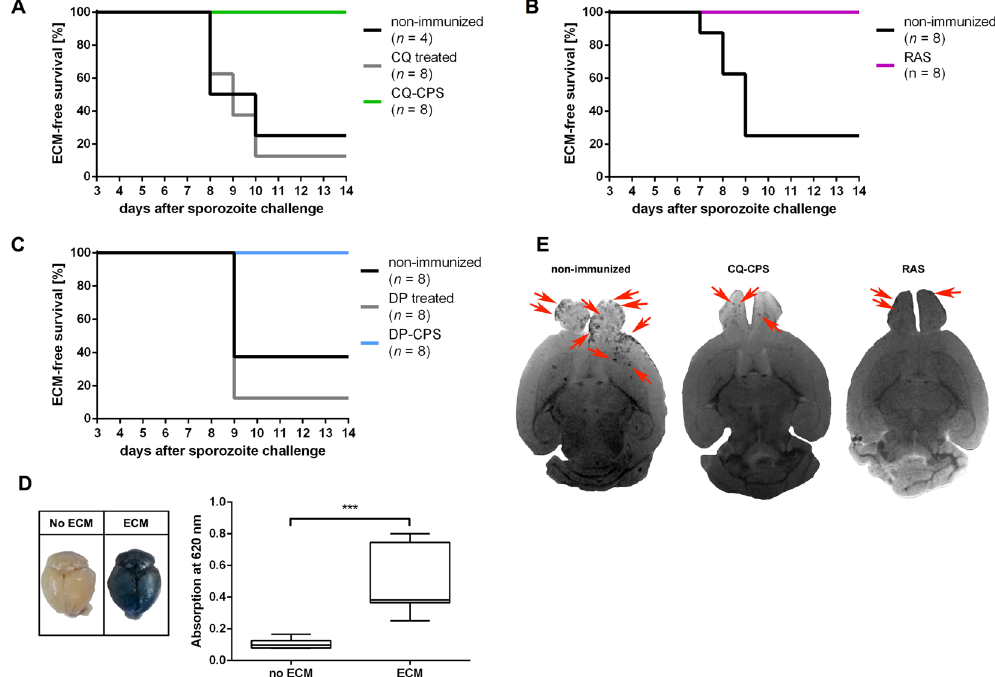
Figure 1. A single CPS or RAS immunization protects mice against experimental cerebral malaria. ( A ) ECM- free survival following a challenge with 10 3 Pb ANKA SPZ i.v. in previously CQ-CPS immunized (n = 8) versus CQ-treated (n = 8) or untreated (non-immunized; n = 4) control animals. (Non-immunized vs. CQ-CPS: P < 0.01; CQ treated vs. CQ-CPS: P < 0.001; Non-immunized vs. CQ treated: P = 0.7, logrank-test). ( B ) ECM- free survival in i.v. RAS immunized (n = 8) versus untreated (non-immunized; n = 8) control animals following a challenge with 10 3 Pb ANKA SPZ i.v. (P < 0.001, logrank-test). ( C ) ECM-free survival in s.c. DP-CPS immunized (n = 8) versus DP treated (n = 8) or untreated (non-immunized; n = 8) animals (Non-immunized vs. DP-CPS: P < 0.01; DP treated vs. DP-CPS: P < 0.001; Non-immunized vs. DP treated: P = 0.26, logrank-test). ( D ) Evans Blue staining of the brains of animals with (right) and without (left) clinical signs of ECM (shown are representative pictures). Following i.v. injection of Evans Blue, significantly higher amounts of Evans Blue were detected in the brains of ECM (n = 10) versus non-ECM (n = 13) animals, (P < 0.001, Wilcoxon rank-sum test). ( E ) Representative MR brain images (MRI assessment) show a high number of microhemorrhages in non- immunized mice with a predominance in the olfactory bulb, while in CQ-CPS and RAS immunized mice only a low number of microhemorrhages is visible (red arrows point to exemplary